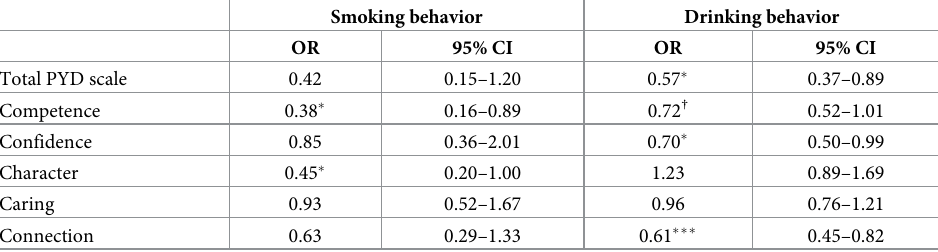
Table 5. Logistic regression odds ratios of total PYD scale on smoking and